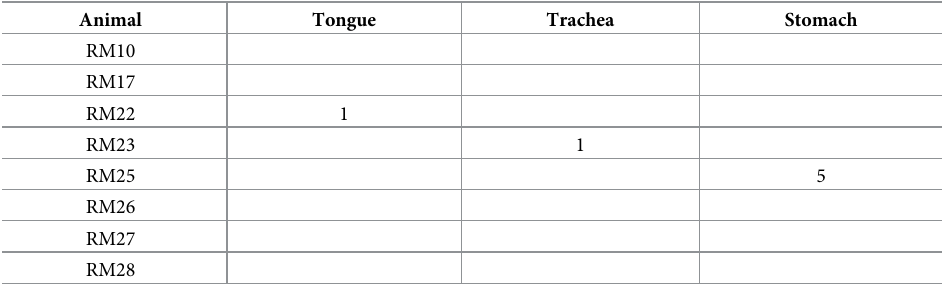
of all tissues, minimal mCherry+ cells were found in only three of the neonates ( Table 2) . However, although we were able to detect and verify mCherry+ cells in a few animals, these cells proved difficult to widely identify due to the high autofluorescent background in the neo- natal tissues. Therefore, tissue sections that contained luciferase activity by IVIS were also stained with antibodies for luciferase. Unfortunately, despite tissues showing luciferase activity by IVIS, positive luciferase signal was not detected in any of the neonatal tissues. Although, we previously used a LICh viral vector in a model of SIV infection in the female reproductive tract to identify sites of viral transduction [31], these data suggest that in our oral viral challenge model, LICh technology may not be as efficient. Therefore, defining SHIV-1157ipd3N4 viral infection, replication, and dissemination in the oral and gut mucosa was prioritized. Most infected cells are found in the small intestine after oral viral challenge To determine which cell types are susceptible to replicative viral infection after oral exposure, tissues were examined for evidence of SHIV-1157ipd3N4 infection using fluorescent deconvo- lution microscopy ( Table 3 ). Tissue sections from the oral cavity and GI tracts of each animal were stained with antibodies directed toward SIV Gag (clone AG3) to identify SHIV- 1157ipd3N4 gag, as well as CD3 and CCR6 to phenotype infected immune cell subsets (Fig 3, Table 3) . Five panels consisting of three 40x by five 40x images were taken for phenotype anal- ysis. As we have previously shown, these markers allow us to identify the target cells as Th17, T cells, immature dendritic cells (iDCs), and other. In the tongues of neonatal RMs, we found very small foci of infection; five of the eight animals examined had SHIV-1157ipd3N4 infected Table 3. Localization of SHIV-1157ipd3N4 infected cells 96 hours after oral challenge by microscopy. Animal Tongue Tonsil